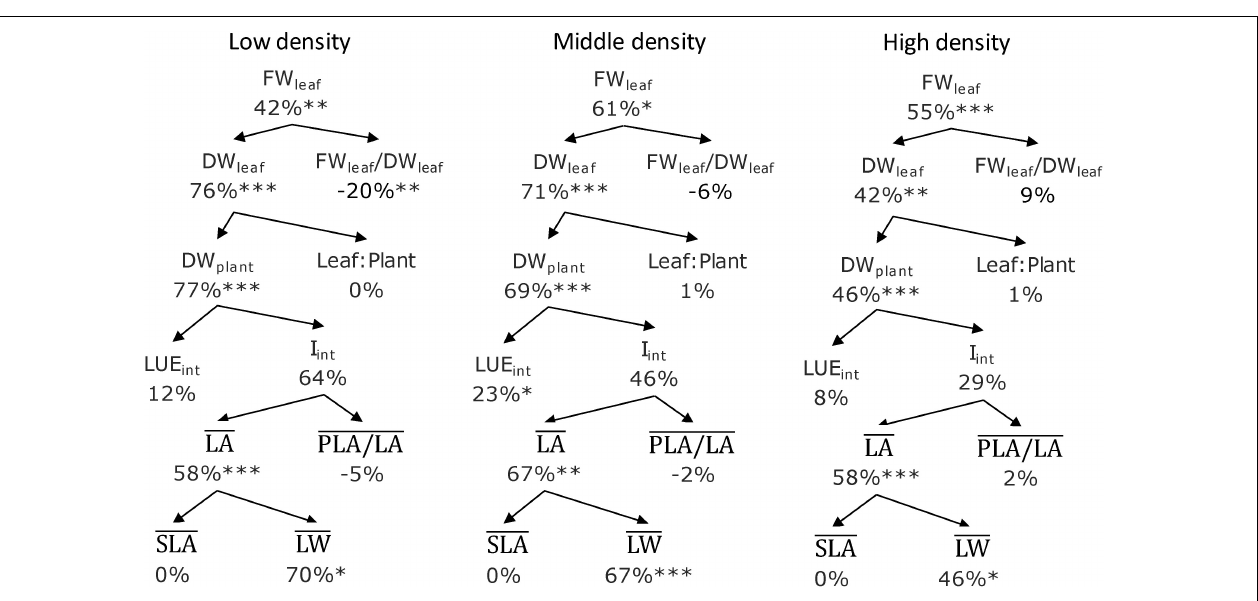
photosynthetic rate increases in short term (Emerson et al.,